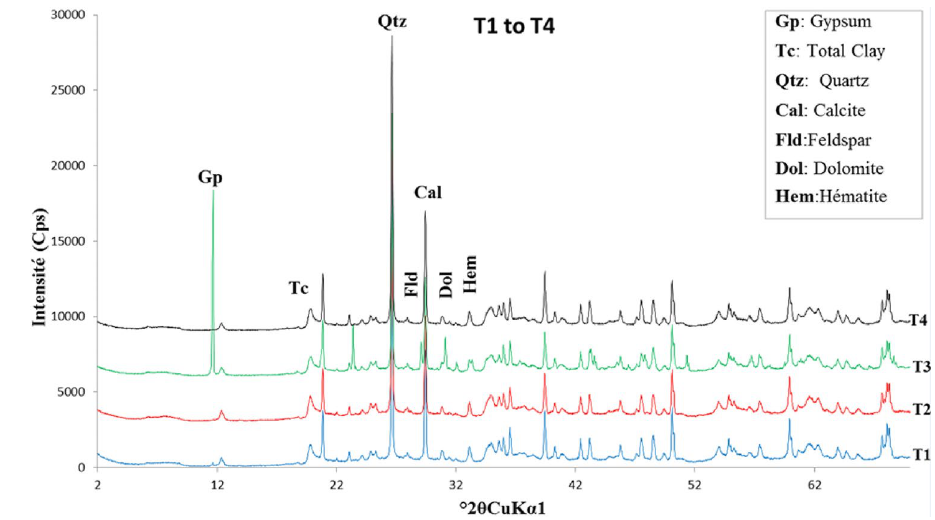
Table 2 Results of the geochemical analysis of the two analyzed samples T1 and T2 by X-ray fluorescence spectrometry